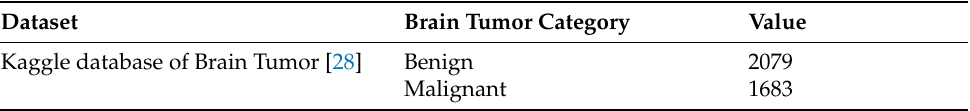
Figure 1. MRI brain images. The image on the left is Benign while the image on the right is Malignant. Table 2. Description of the